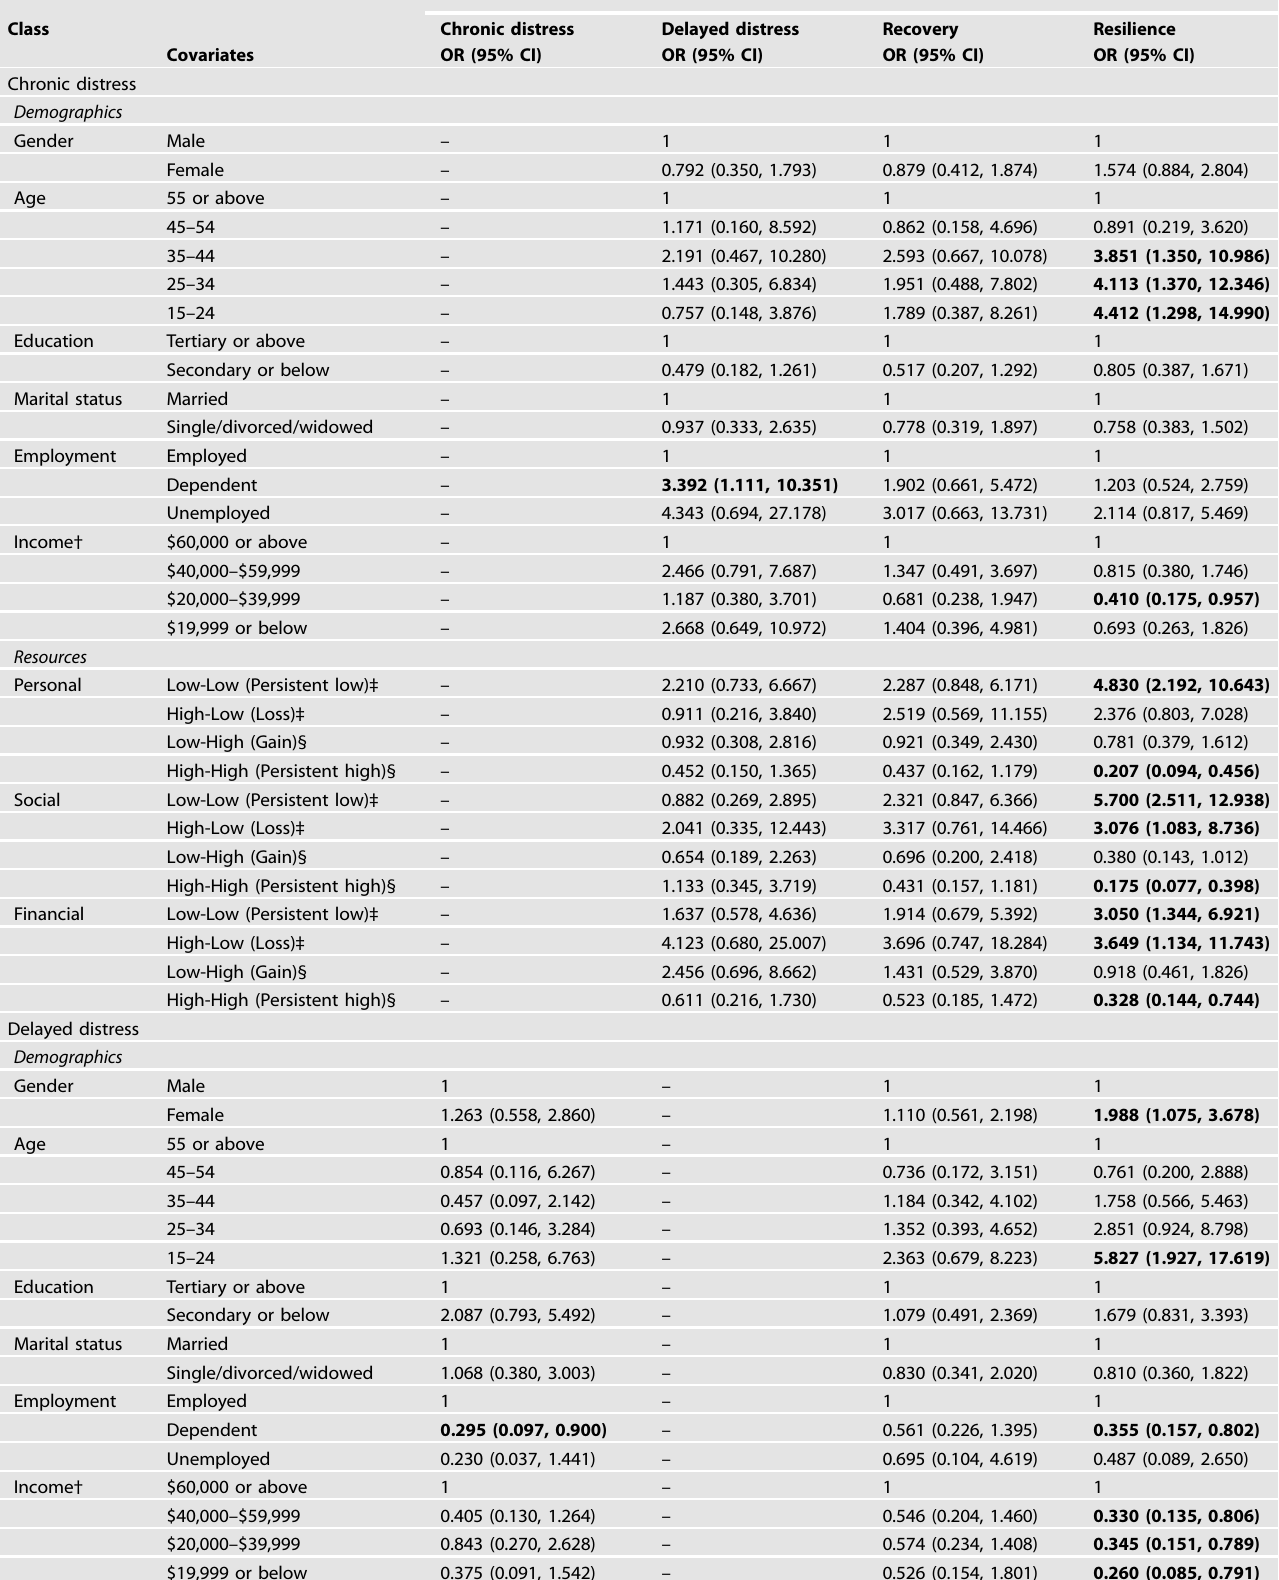
Table 4. Conditional growth mixture modeling (GMM) results of anxiety symptom